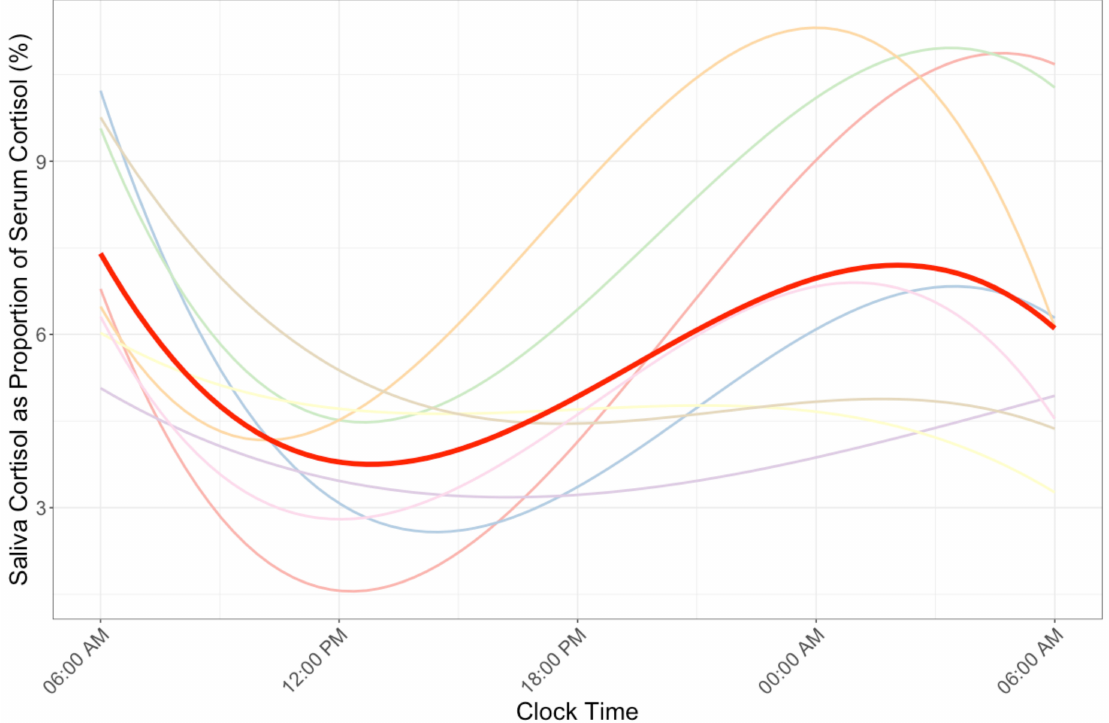
Figure 3. Saliva cortisol as a proportion of serum cortisol across the 24-h profile. The best fitting model demonstrated a cubic circadian rhythm. The mean profile is depicted in